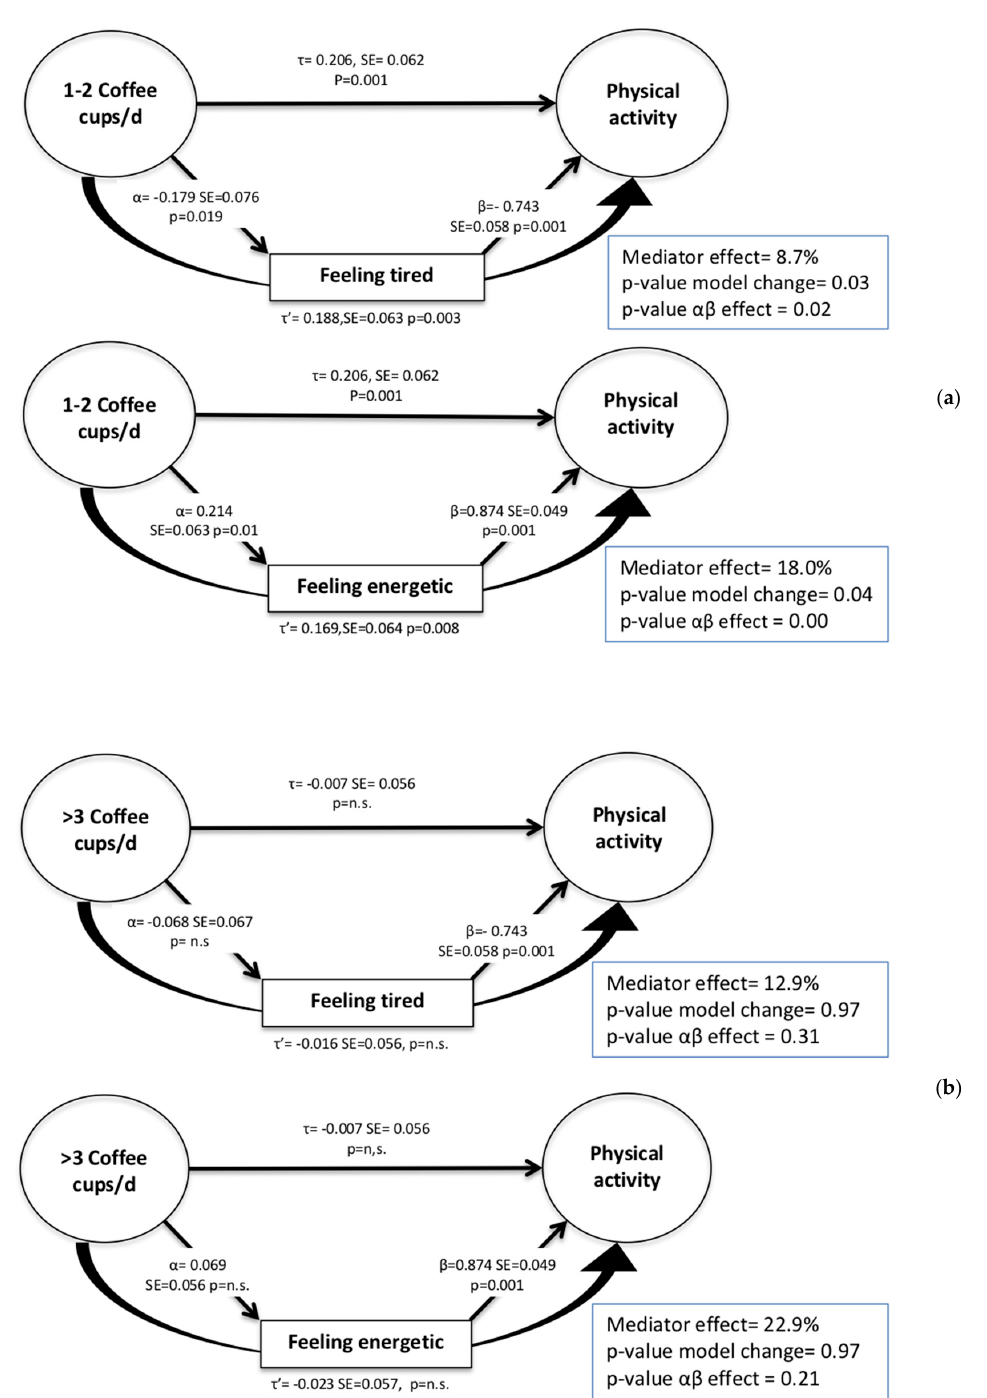
Figure 1. Mediation analysis for the relationship between coffee consumption and meeting physical activity guidelines for ( a ) 1–2 cups of coffee/day and ( b ) >3 cups of coffee/day, with correlation coefficients before ( τ ) and after ( τ ’) including the mediator in the model. Mediator effect: ( τ − τ ’)/ τ = % difference in the regression coefficient for the independent variable (coffee intake) on the dependent variable (physical activity) between the models. p -value model change = tests the hypothesis that the direct effect of IV on DV is statistically significant after adjusting for the mediator; p -value αβ effect = tests the hypothesis that the indirect effect of the mediator on the IV–DV relationship is significantly different from zero.